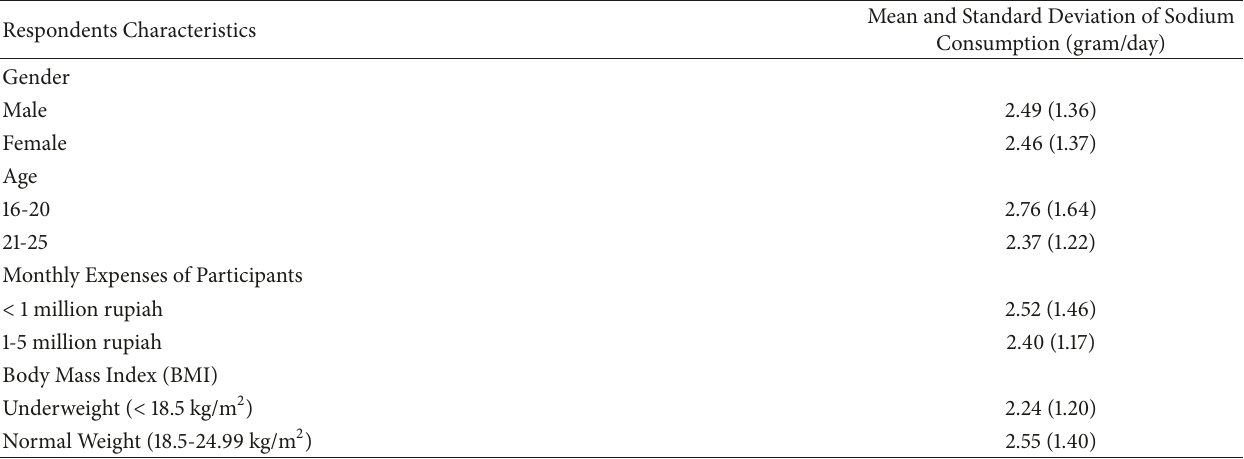
Table 2: Description of Respondents’ Characteristics.